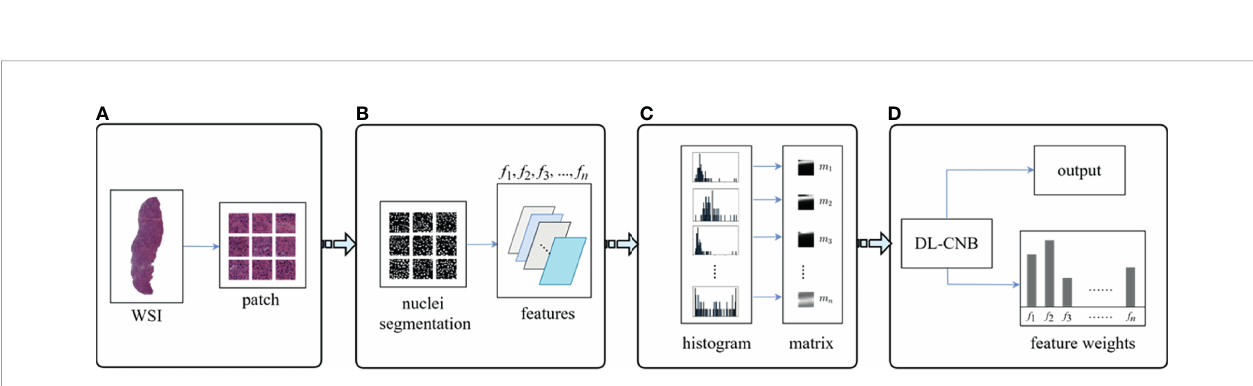
FIGURE 3 | Overview on interpretability methods of deep learning core-needle biopsy (DL-CNB) model based on nucleus morphometric features. (A) The selected tumor regions of each whole-slide image (WSI) was cropped into patches. (B) For each patch, we processed nucleus segmentation (a weakly supervised segmentation framework was applied to obtain the nucleus), de fi ned multiple nucleus morphometric features (such as major axis, minor axis, area, orientation, circumference, density, circularity, and rectangularity, which are denoted as f 1 , f 2 , f 3 , … , f n ), and extracted n feature parameters correspondingly. (C) All n kinds of feature parameters from a WSI were quantized into n distribution histograms and saved to n feature matrices ( m 1 , m 2 , m 3 , … , m n ). (D) The matrices from a WSI were considered as instances of a bag and served as the input of DL-CNB model; the re-trained DL-CNB model could generate scores of features (instances) in the bag, which represented the weight of each feature in pathological diagnosis.